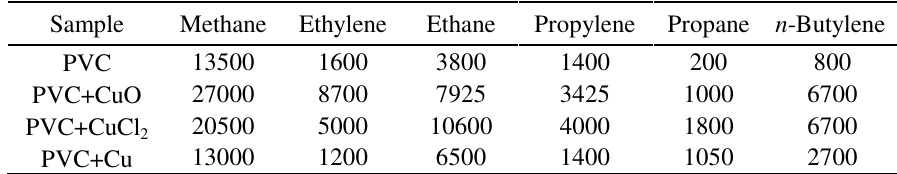
Table 3 . Concentration (ppm) of short chain gases produced by the pyrolysis of PVC alone and in the presence of some copper compounds under nitrogen.